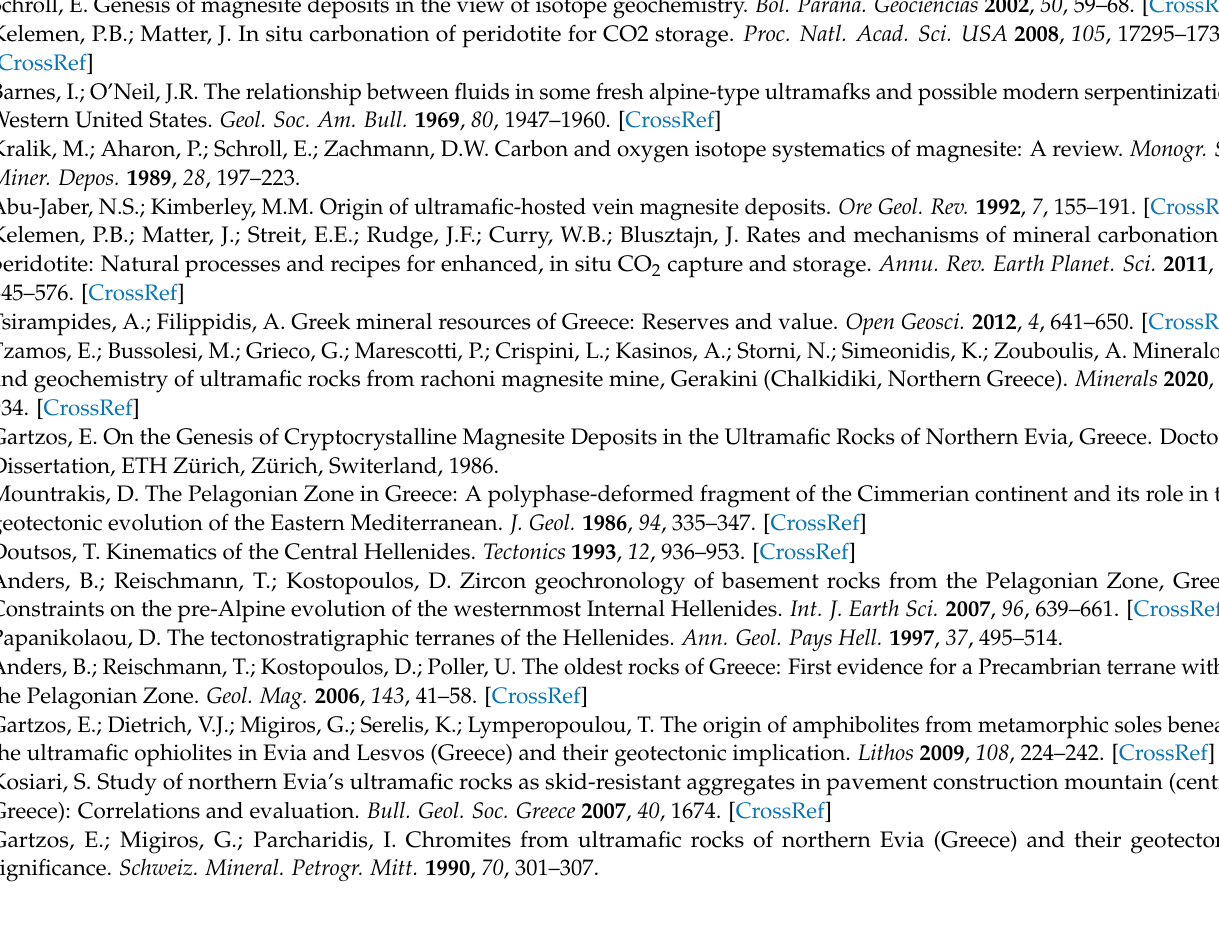
Table S3: spi-nel-chromitite; Table S4: